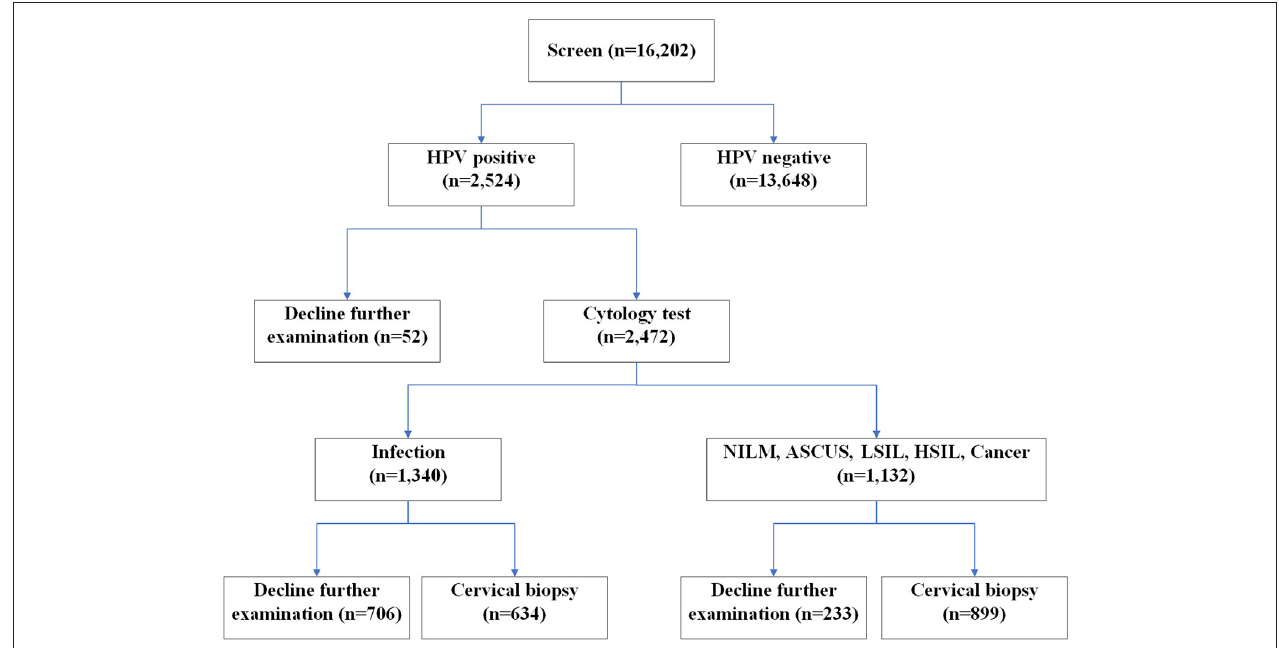
FIGURE 1 | Flow chart of study